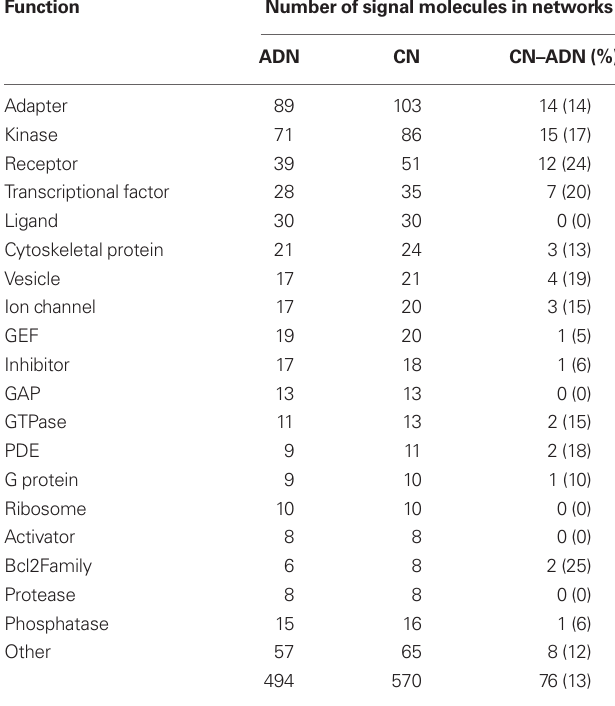
Table 1 | Number of constituent signal molecules on CN and ADN. “Other” denotes small molecules or histones. The actual connection graph of the 570 nodes and 1,333 edges of CN and the 494 nodes and 974 edges of ADN is shown. We extracted 76 Alzheimer’s disease-related signal molecules known to decrease actin, beta-catenin, and CaMKII. This group of genes represents 13% of the CN. By observing the pathway functions of these 76 Alzheimer’s disease-related signal molecules, we discovered that nodes in the Bcl2Family and Receptor groups decreased at a rate greater than the network as a